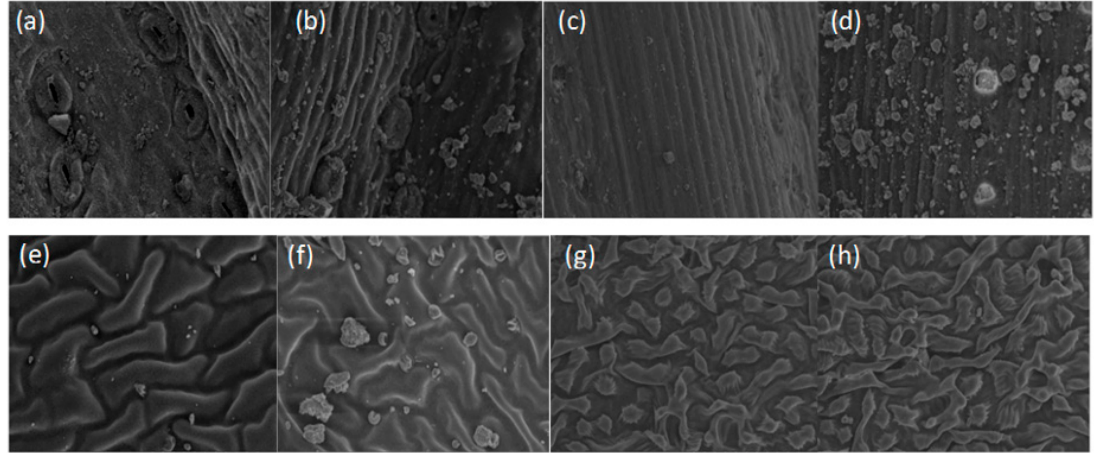
Figure 13. Scanning electron micrographs of leaf surfaces before and after dust storm. Platycladus orientalis , ( a ) before dust storm, ( b ) after dust storm. Pinus tabulaefolius , ( c ) before dust storm, ( d ) after dust storm. Ginkgo biloba , adaxial surface, ( e ) before dust storm, ( f ) after dust storm; abaxial surface, ( g ) before dust storm, ( h ) after dust storm.